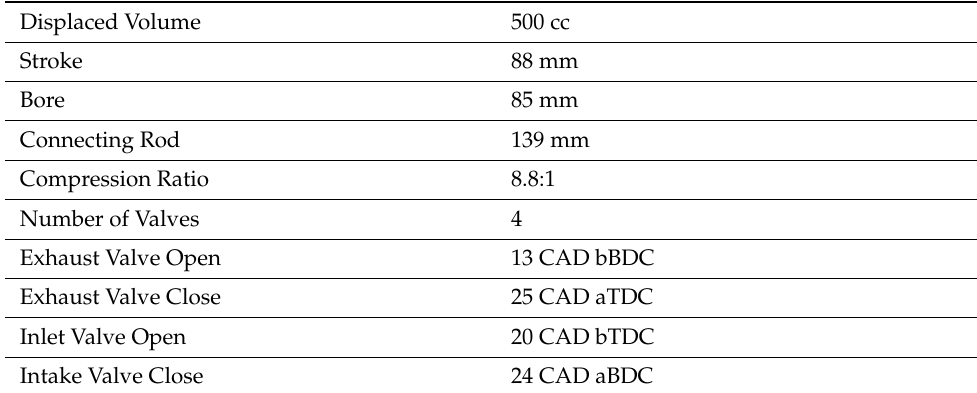
Table 1. Main features of the optical access